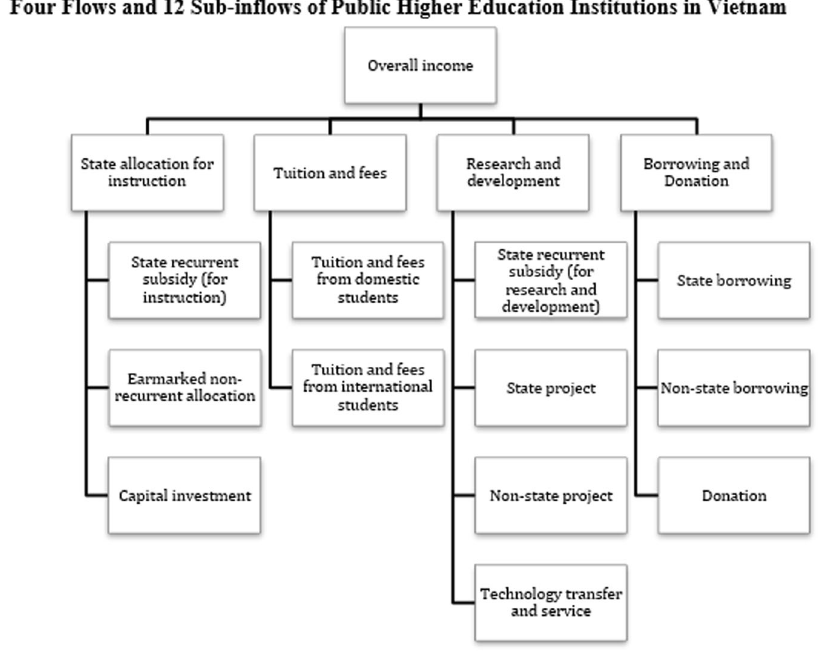
Fig. 1 Four fl ows and 12 sub-in fl ows of Public Higher Education Institutions in Vietnam. Table 2 Descriptive pro fi le of 51 surveyed